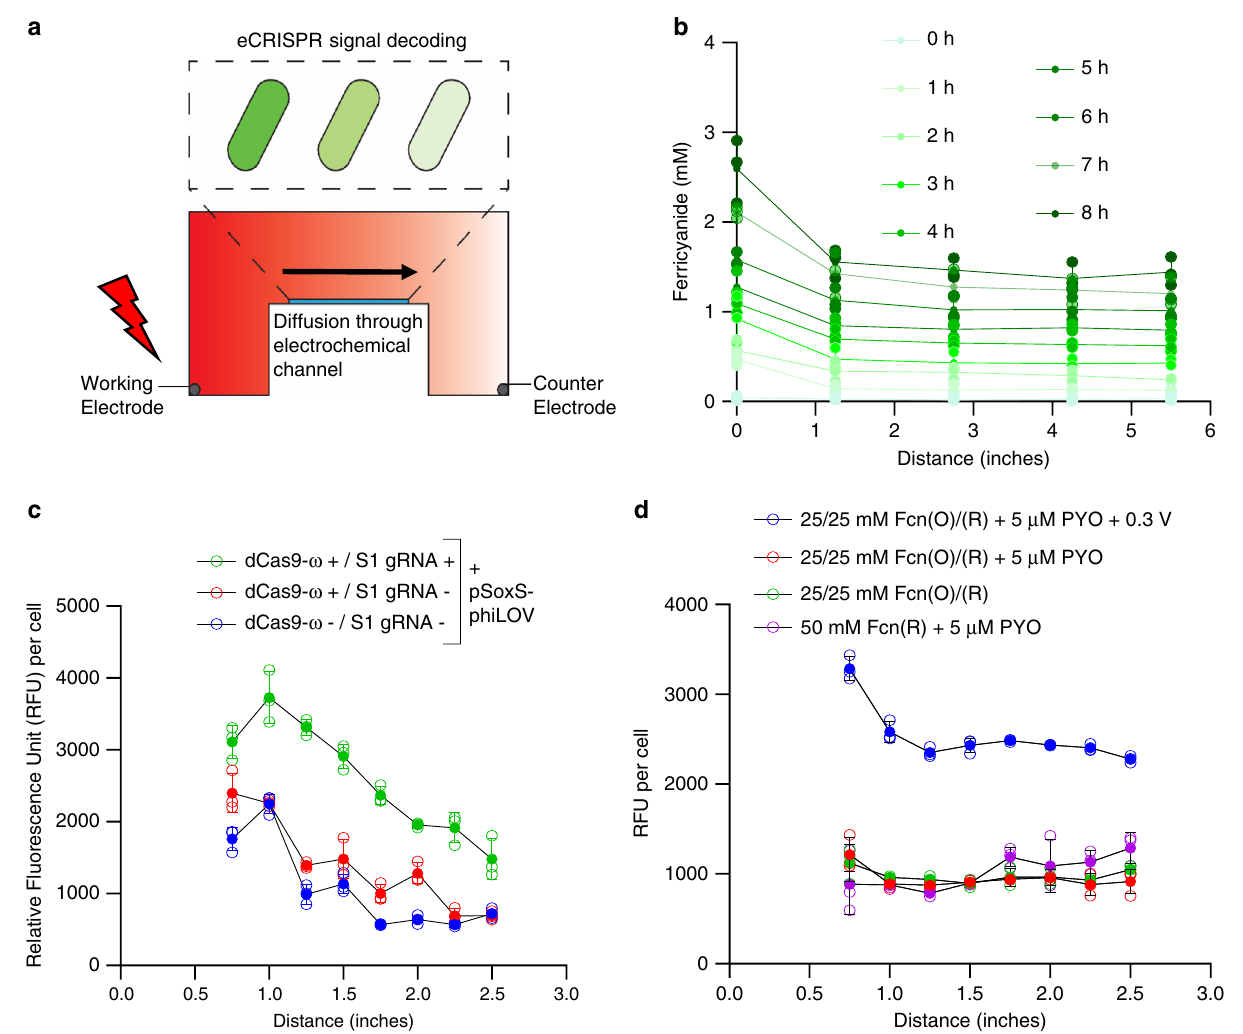
Fig. 5 Spatiotemporal electronic control of eCRISPR. a Scheme of the gel apparatus used to generate ferricyanide gradient upon electrical induction. An Owl easy cast gel electrophoresis system is fi lled with minimal-M9 media and supplemented with 50 mM Fcn(R). The left chamber is connected to the working electrode and the right chamber to the counter and both are connected to a potentiostat. Additionally, an Ag/AgCl is used as a reference electrode located in the left chamber. The entire apparatus is assembled and used inside an anaerobic chamber. To generate a gradient, an oxidizing potential of + 0.3 V is provided across the gel apparatus. To study the effect of gradients on cells, cells are immobilized in gelatin hydrogels and cast onto microscope slides. Different cell populations are immobilized and the slides are placed at the center of the gel apparatus to expose the cells to the gradients. b Data indicating the formation of the ferricyanide gradient in the gel apparatus. An oxidizing potential of + 0.3 V is applied across 8 h under anaerobic conditions and at each hour, aliquots are collected from various points in the gel apparatus and the amount of Fcn(O) present in the sample is measured via absorbance at 420 nm. To study the effect of Fcn(O) gradients on various cell populations, cells are assembled in gelatin hydrogels on slides and placed in the gel apparatus. After 8 h of electrical induction with + 0.3 V, slides are removed and analyzed for phiLOV fl uorescence using scanning laser confocal microscopy. Each data point consists of average fl uorescence of 10,000 cells. c , d indicate cell fl uorescence data from various experimental and control conditions noted in the text. In all fi gs, independent experimental replicates ( n = 3) are represented by empty circles, mean indicated by fi lled circles and error bars indicate standard deviation. Source data for all fi gures is provided